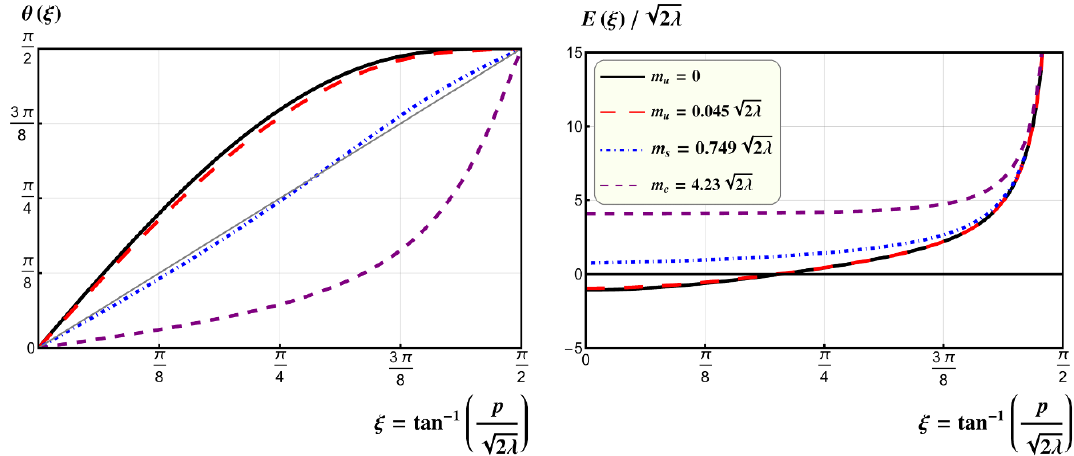
Figure 2 . Bogoliubov (chiral) angle (cid:18) ( p ) and dressed quark energy E ( p ) as functions of (cid:24) = tan (cid:0) 1 p p for di(cid:11)erent current quark mass. 2 (cid:21) (cid:18) ( p ) is an odd, and, monotonically rising function in p , which approaches respectively. It turns out to be an impossible mission to express (cid:18) ( p ) in terms of